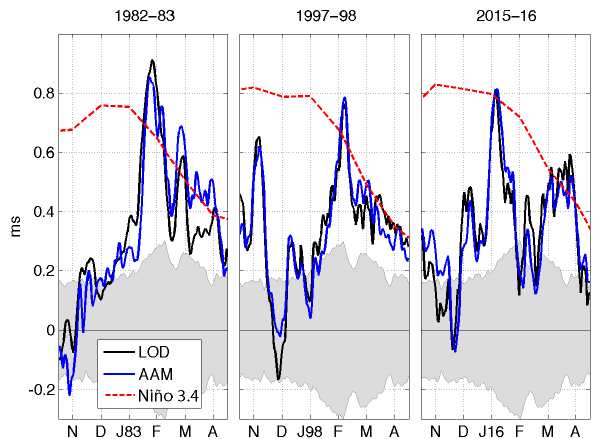
Figure 2. The time series of daily AAM (blue) and LOD (black) values around the three extreme events. The red dashed line repre- sents the scaled monthly Niño 3.4 index. The shaded area represents 1 standard deviation around the climatological mean. The x -axis ticks indicate the first day of each